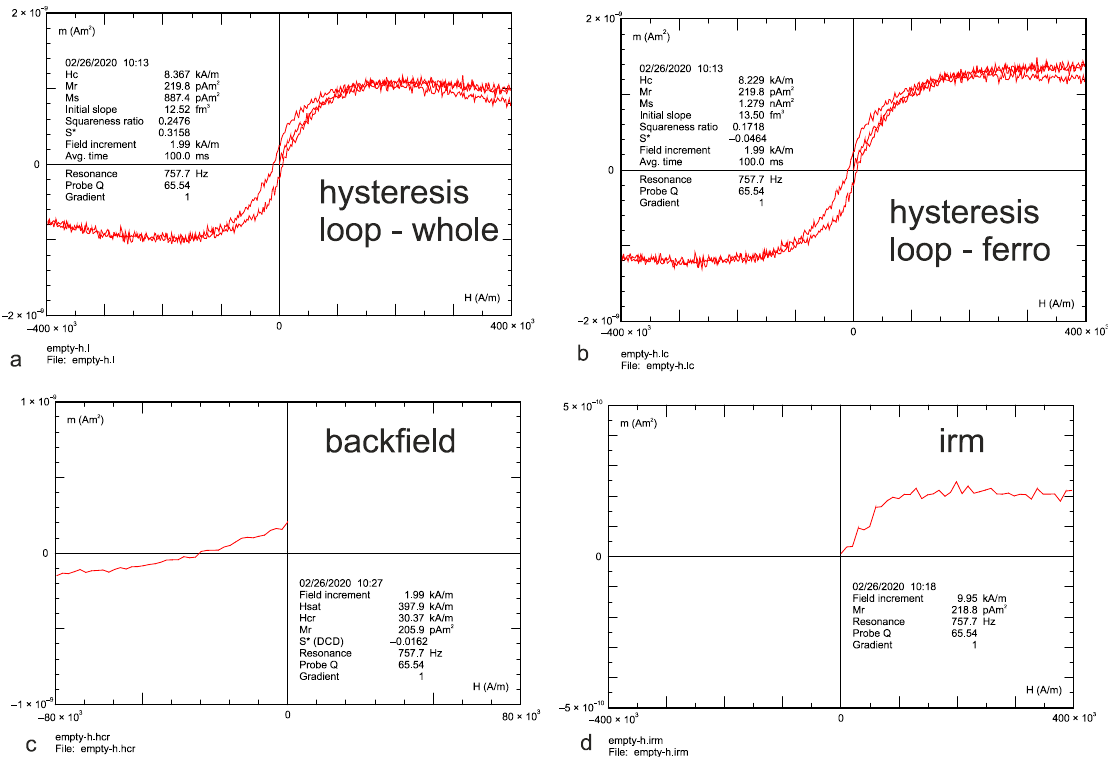
Figure 11. Hysteresis data for an empty filter placed in the quartz holder; ( a ) the whole hysteresis loop, with peak field of 500 mT; ( b ) after slope correction, ferromagnetic contribution to the hysteresis loop, high field linear component removed (here diamagnetic); ( c ) backfield data—Hcr—coercivity of remanence value after DC magnetization at the field of 500 mT; ( d ) isothermal remanence magnetization (IRM) acquisition curve after prior DC demagnetization of the sample with peak 500 mT field. Data plotted after removing the signal of the quartz holder.